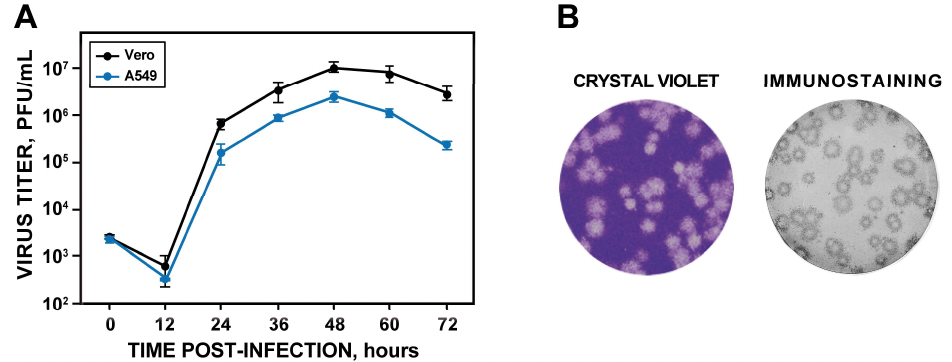
Figure 3. Viral growth kinetics and plaque phenotype of rZIKV-RGN. ( A ) Growth kinetics. Vero and A549 cells at 90% confluence (24-well plate format; triplicates) were infected at a multiplicity of infection (MOI) of 1 PFU/cell and at the indicated hpi, virus titers in the tissue culture supernatants were determined by plaque assay on Vero cells. Error bars represent standard deviations of the mean from three experiments. ( B ) Plaque morphology. Vero cells at 90% confluence (6-well plate format) were infected with 50 PFU of rZIKV-RGN and at four days post-infection viral plaques were visualized by staining with crystal violet (left) or immunostaining (right) using the pan-flavivirus E protein mAb